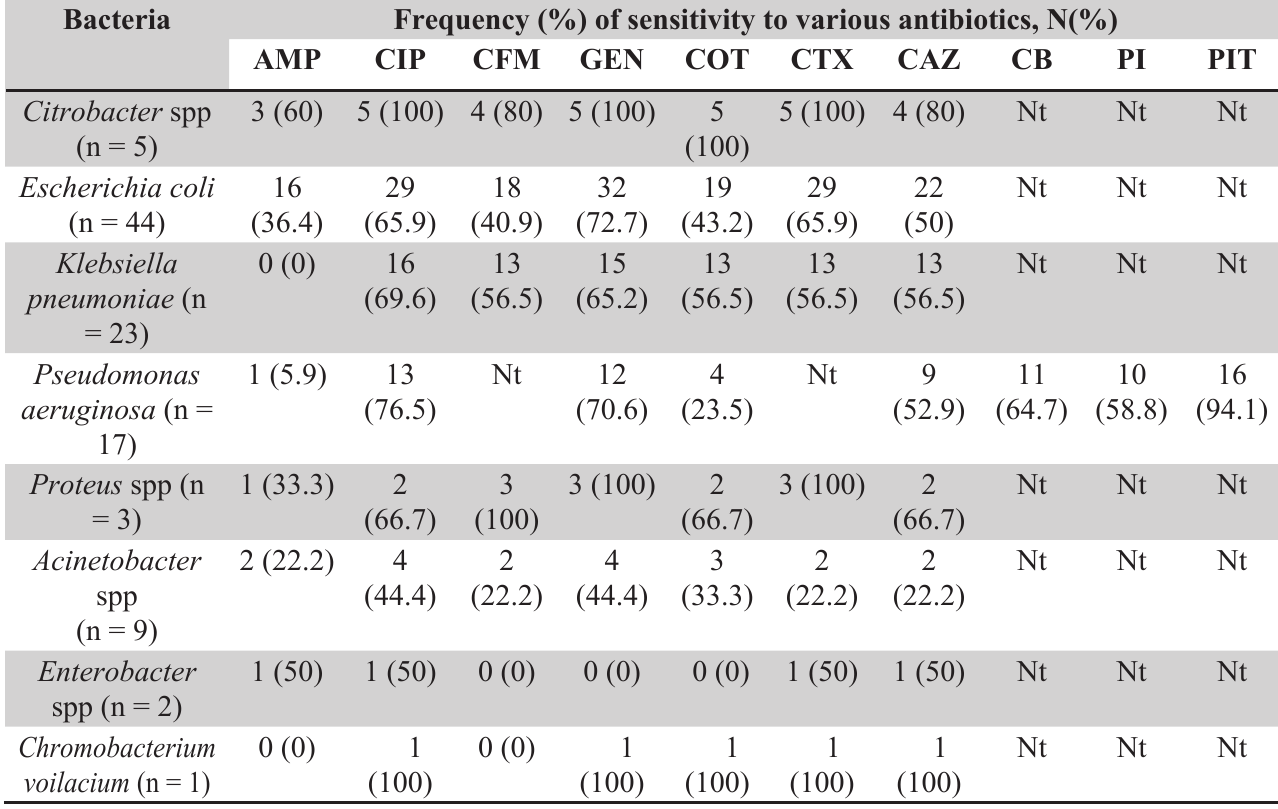
Table 3. Antibiotic sensitivity pattern of gram-negative bacteria.